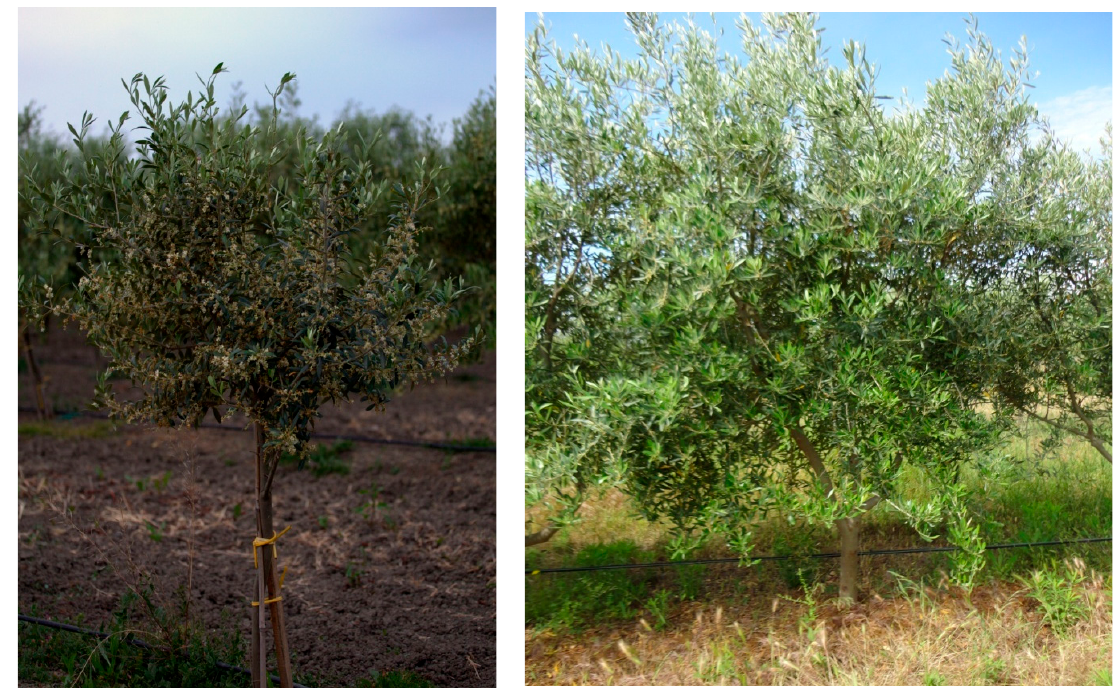
Figure 1. Young ( left ) and adult ( right ) ‘Lecciana’ trees.